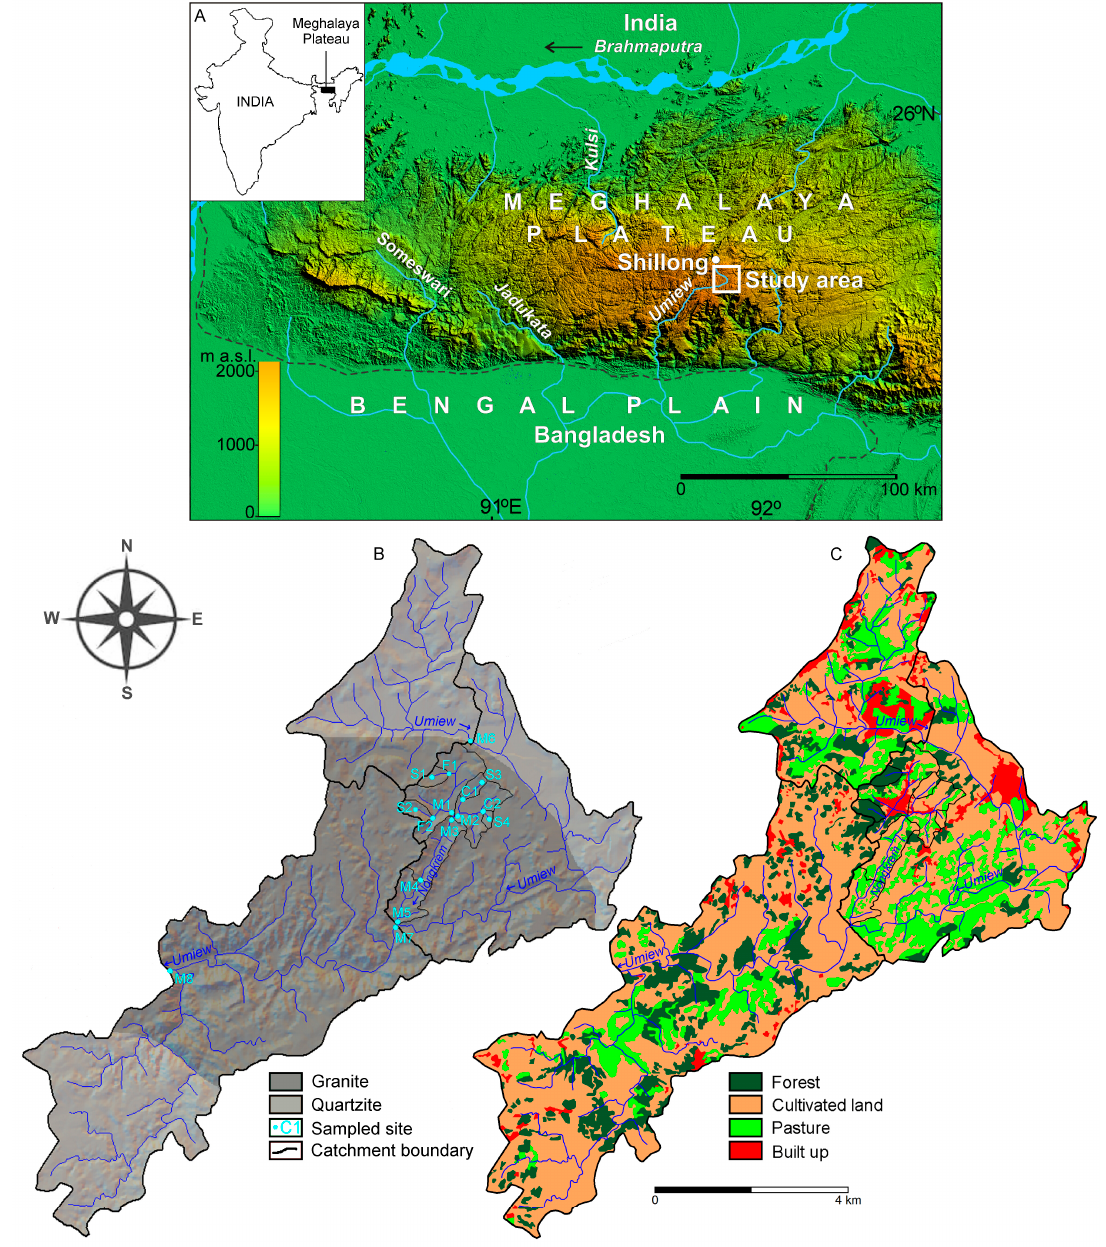
Figure 1. Location of the study area in the Meghalaya Plateau ( A ), geology and sampled sites ( B ), and land use ( C ) in the Nongkrem and Umiew nested catchments system.